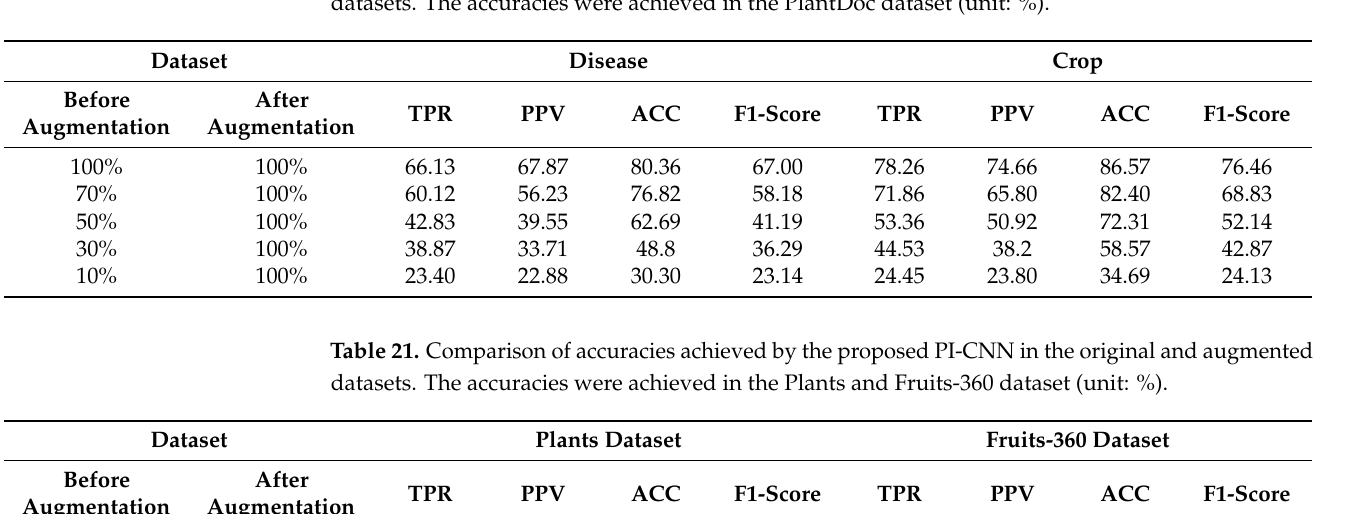
Table 20. Comparison of accuracies achieved by the proposed PI-CNN in the original and augmented datasets. The accuracies were achieved in the PlantDoc dataset (unit: %).